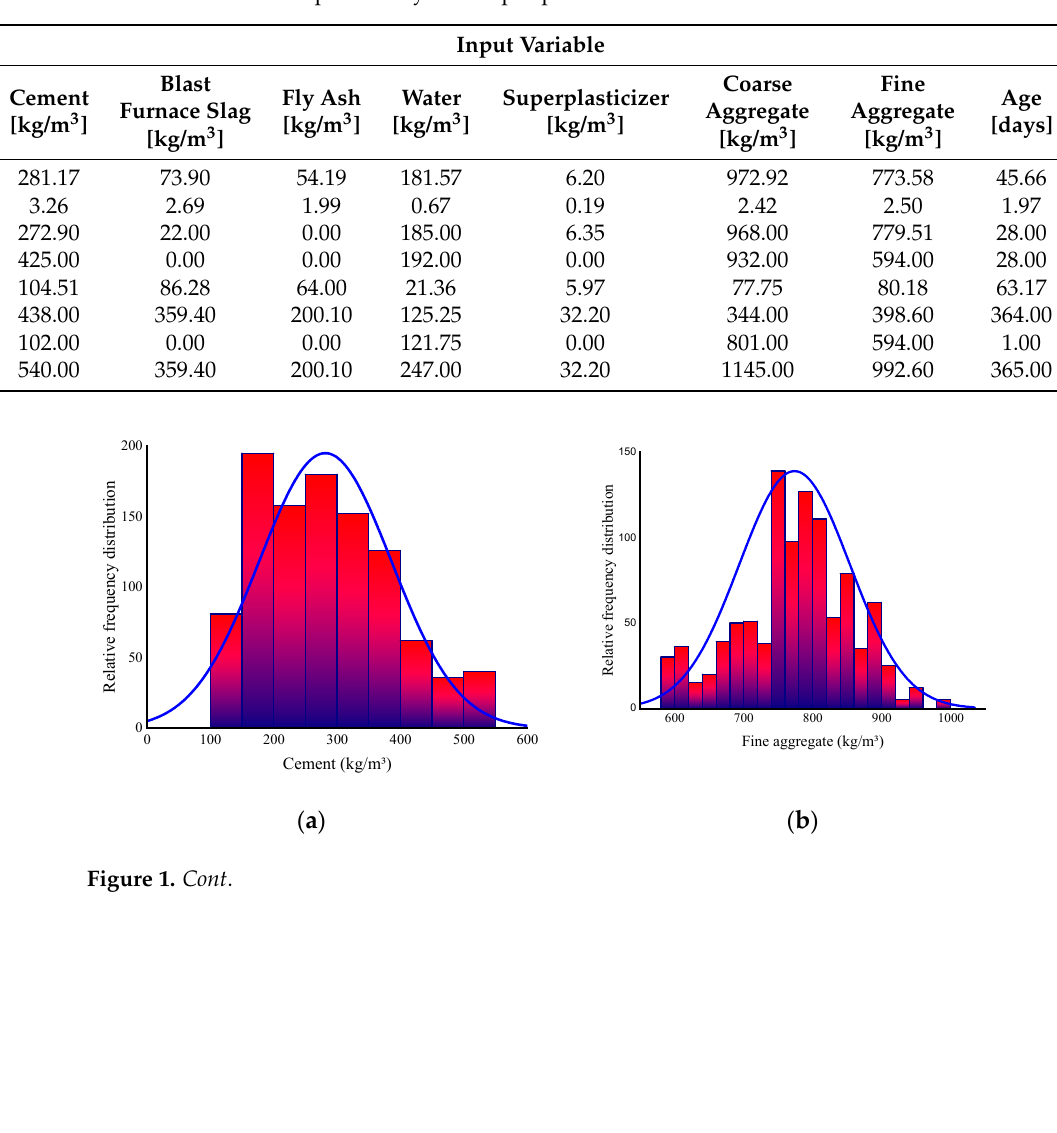
Table 1. Descriptive analysis of input parameters.